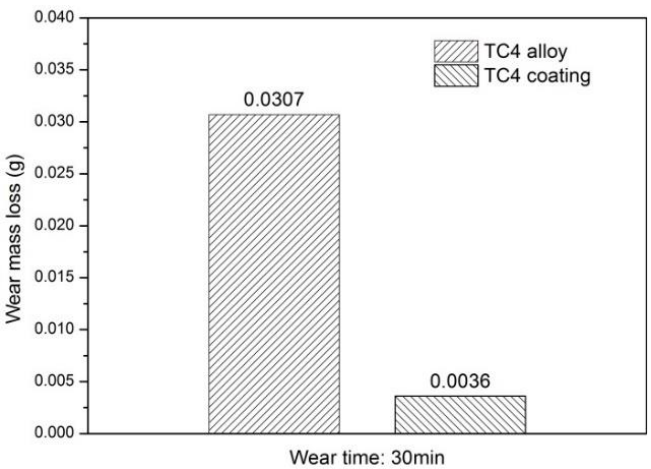
Figure 8. Wear mass loss of the substrate and the coating.